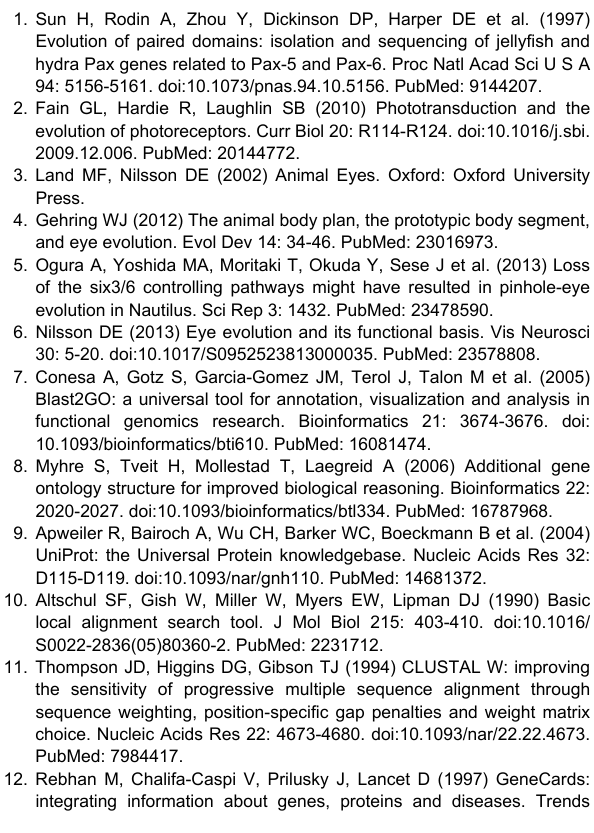
(TIF) Figure S2. Alignment of squid and Nautilus contigs that have best hits with Drosophila and Human Gef26/ RAPGEF2 homologues respectively. Asterisk(*) indicates sequence identity. (TIF) Figure S3. Alignment of squid and Nautilus contigs that have best hits with Drosophila and Human CG5198/ CD2BP2 homologues respectively. Asterisk(*) indicates sequence identity.